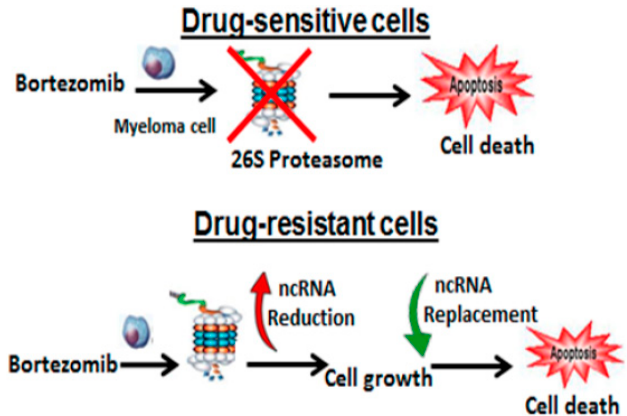
Figure 6. Model for lncRNA replacement therapy in MM. Bortezomib inhibits the proteasome in drug ‐ sensitive MM cells leading to cell death. lncRNAs are reduced in drug ‐ resistant myeloma cells leading drug-sensitive MM cells leading to cell death. lncRNAs are reduced in drug-resistant myeloma to drug ‐ resistance. Replacement of synthetically ‐ engineered lncRNAs restores sensitivity to proteasome inhibitors and overcomes drug resistance.